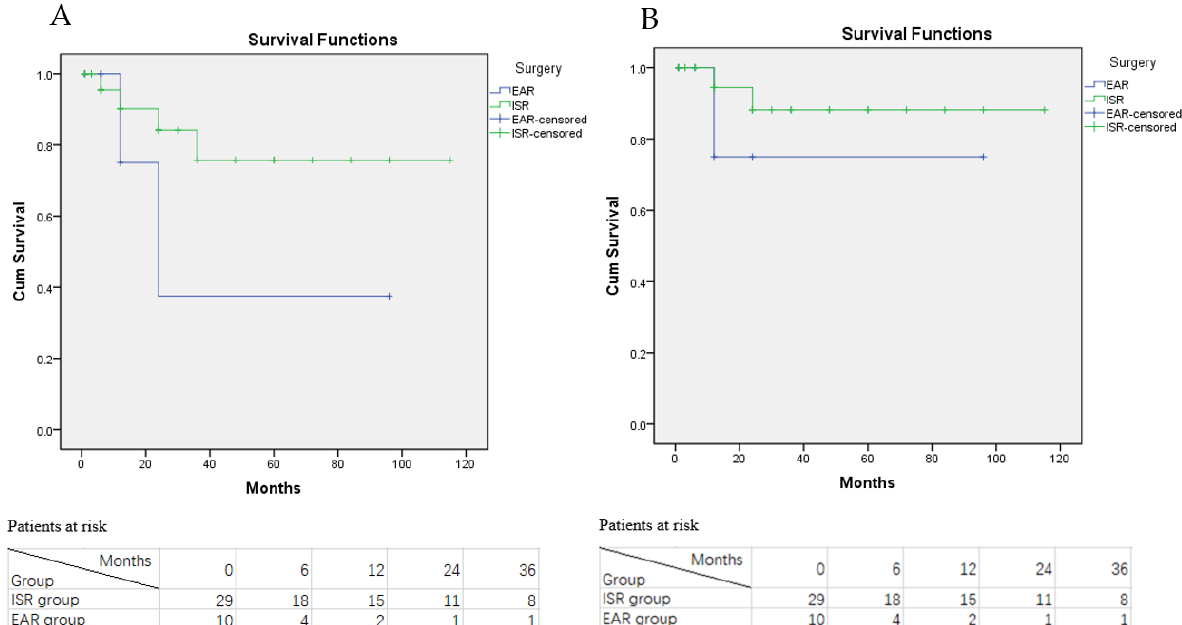
Figure 5. Kaplan-Meier survival curve of graft patency grouped by different treatment option. ( A ) KM curve of primary graft patency of ISR and EAR group with numbers of patients at risk; ( B ) KM curve of secondary graft patency of ISR and EAR group with numbers of patients at risk.